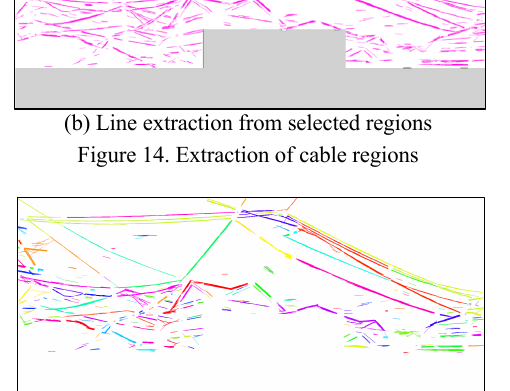
Figure 15. Lines